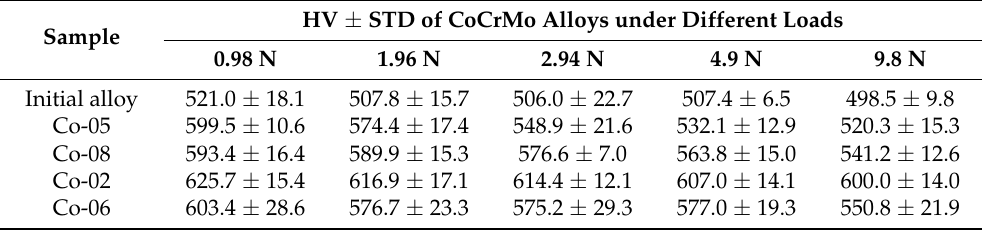
Table 2. Hardness (HV) and standard deviation (STD) of CoCrMo alloys recycled by EBMR.